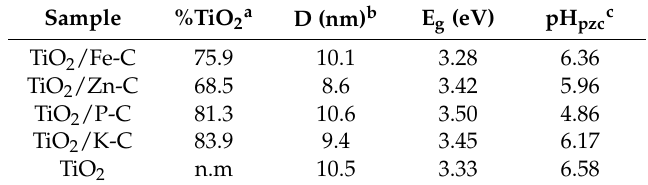
Figure 1. XRD patterns of the TiO 2 /activated carbon heterostructures and bare TiO 2 . Characteristic peaks of anatase phase (JCPDS-78–2486) are indicated (*). Table 2. TiO 2 content, average crystal size (D), band gap (E g ) and pH pzc of the